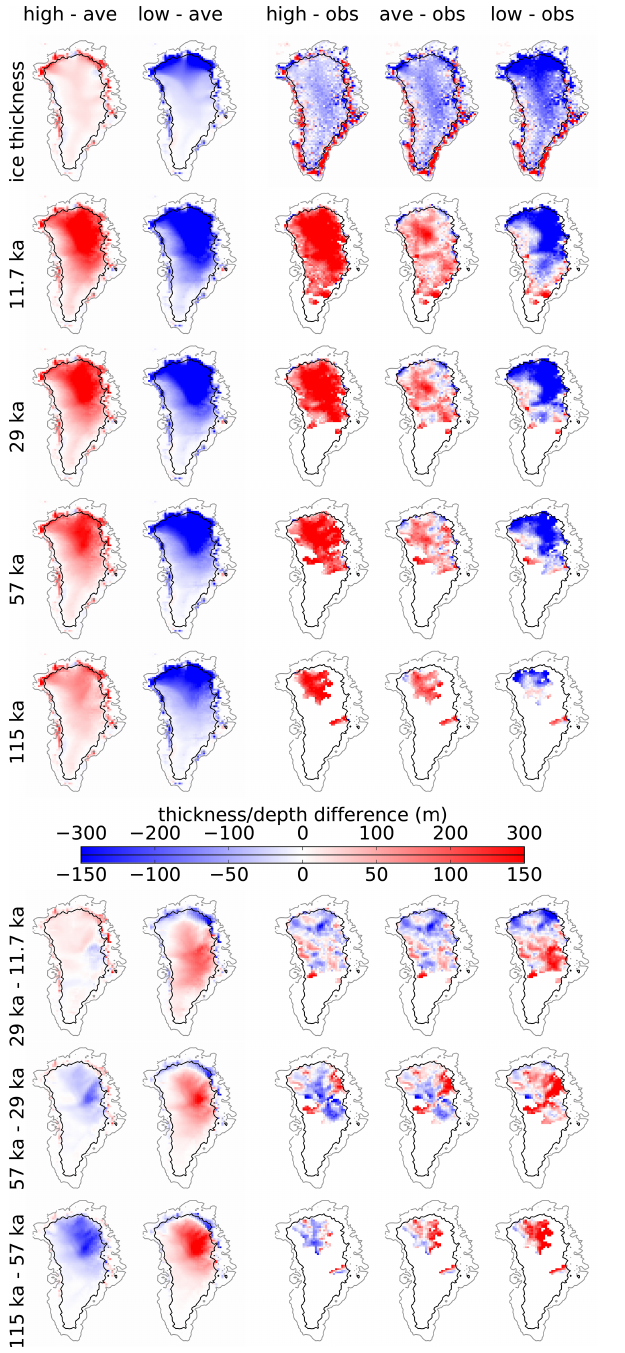
Figure A1. Composite ice thickness and isochrone depth for simulations with high ( − 0.1 to − 0.05myr − 1 ) and low (0.15 to 0.2myr − 1 ) values of (cid:49)P hol compared to the ensemble average and observations. A thin black line marks the 1000m surface elevation.